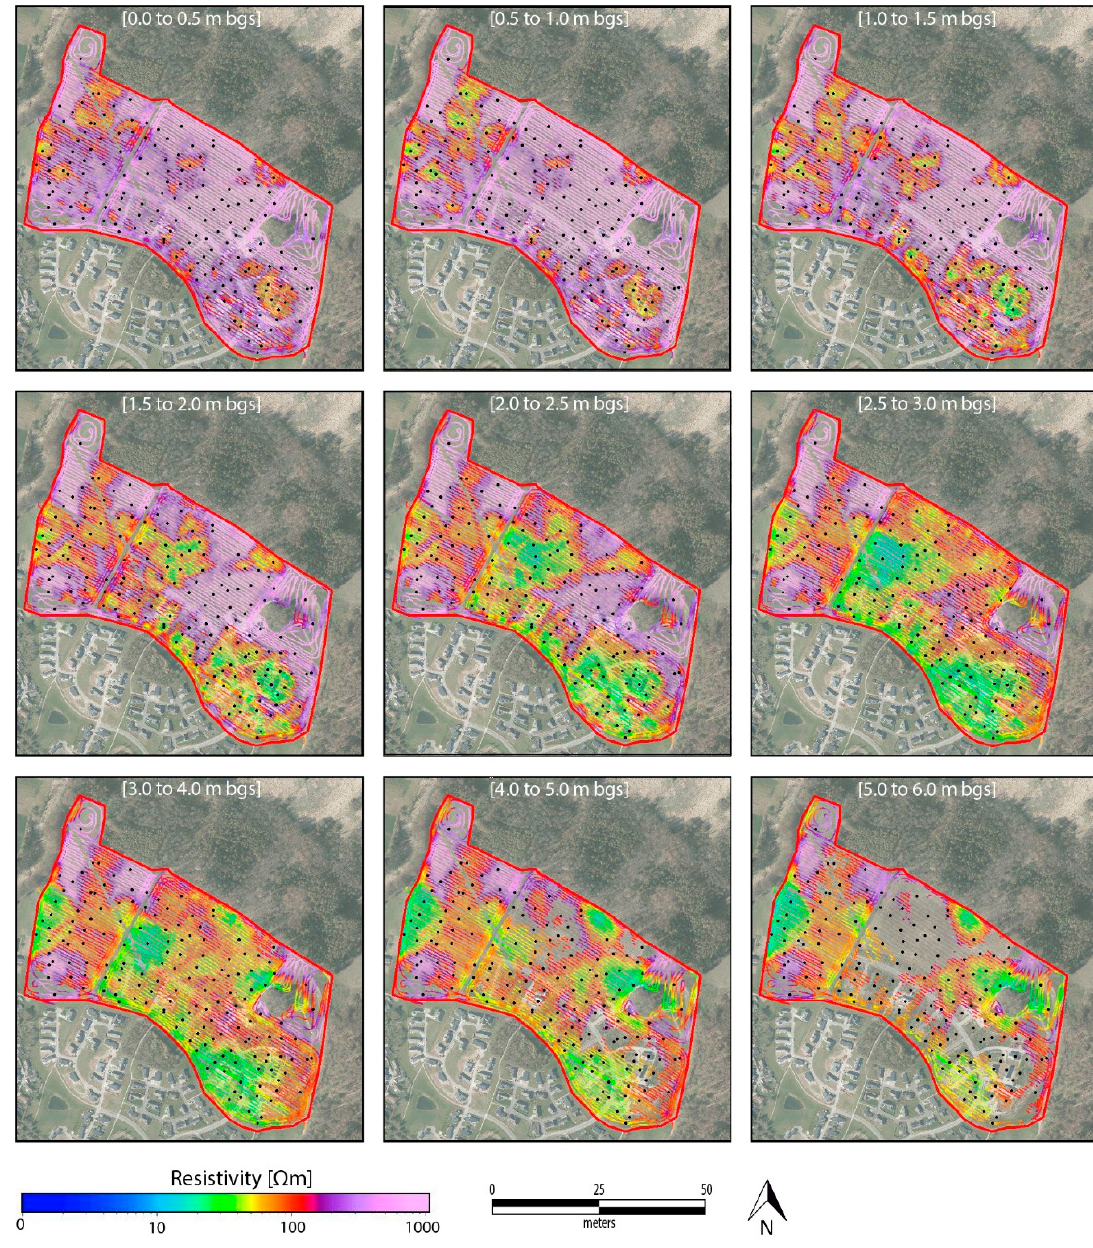
Figure 7. Interval resistivity maps from selected depths. The black dots represent drillings.